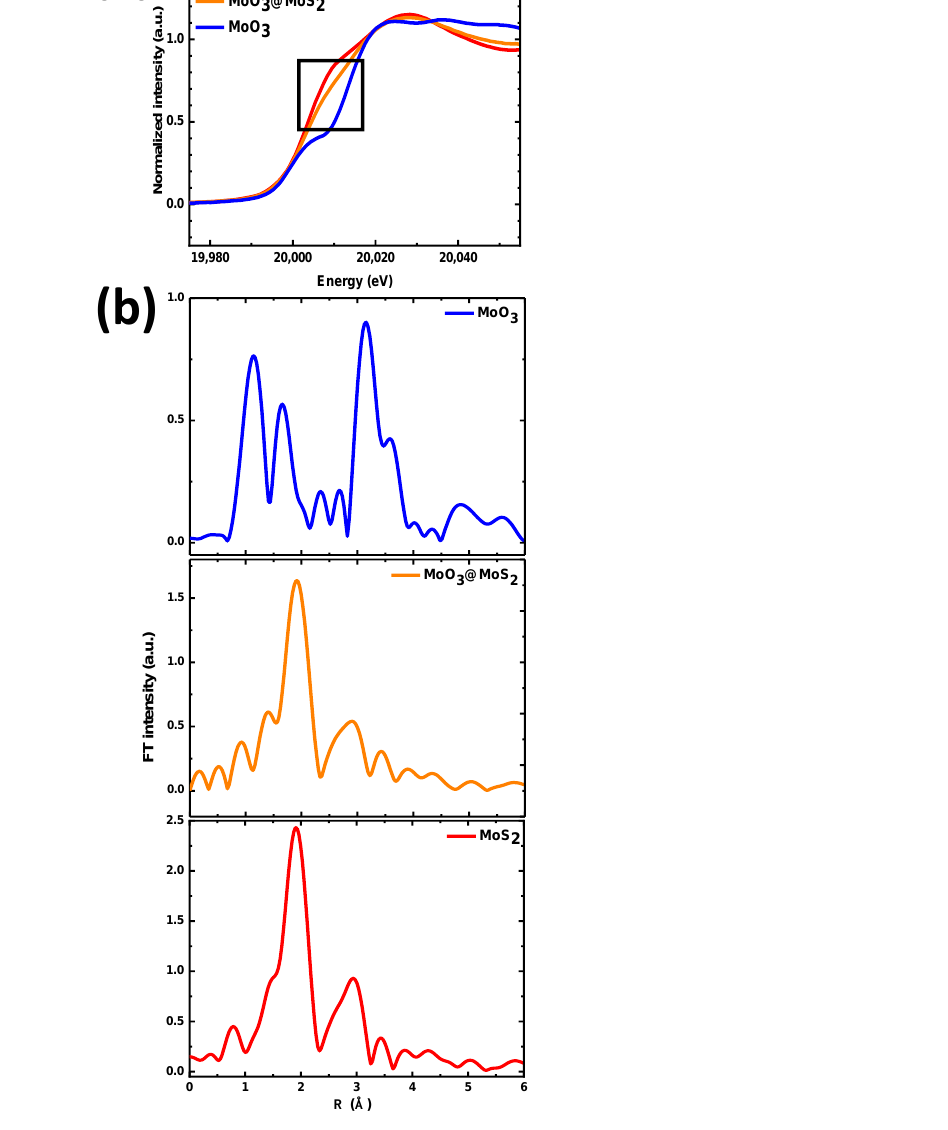
Figure 4. Mo K-edge ( a ) XANES, and ( b ) FT-EXAFS spectra, of MoS 2 , MoO 3 @MoS 2 , and MoO 3 .